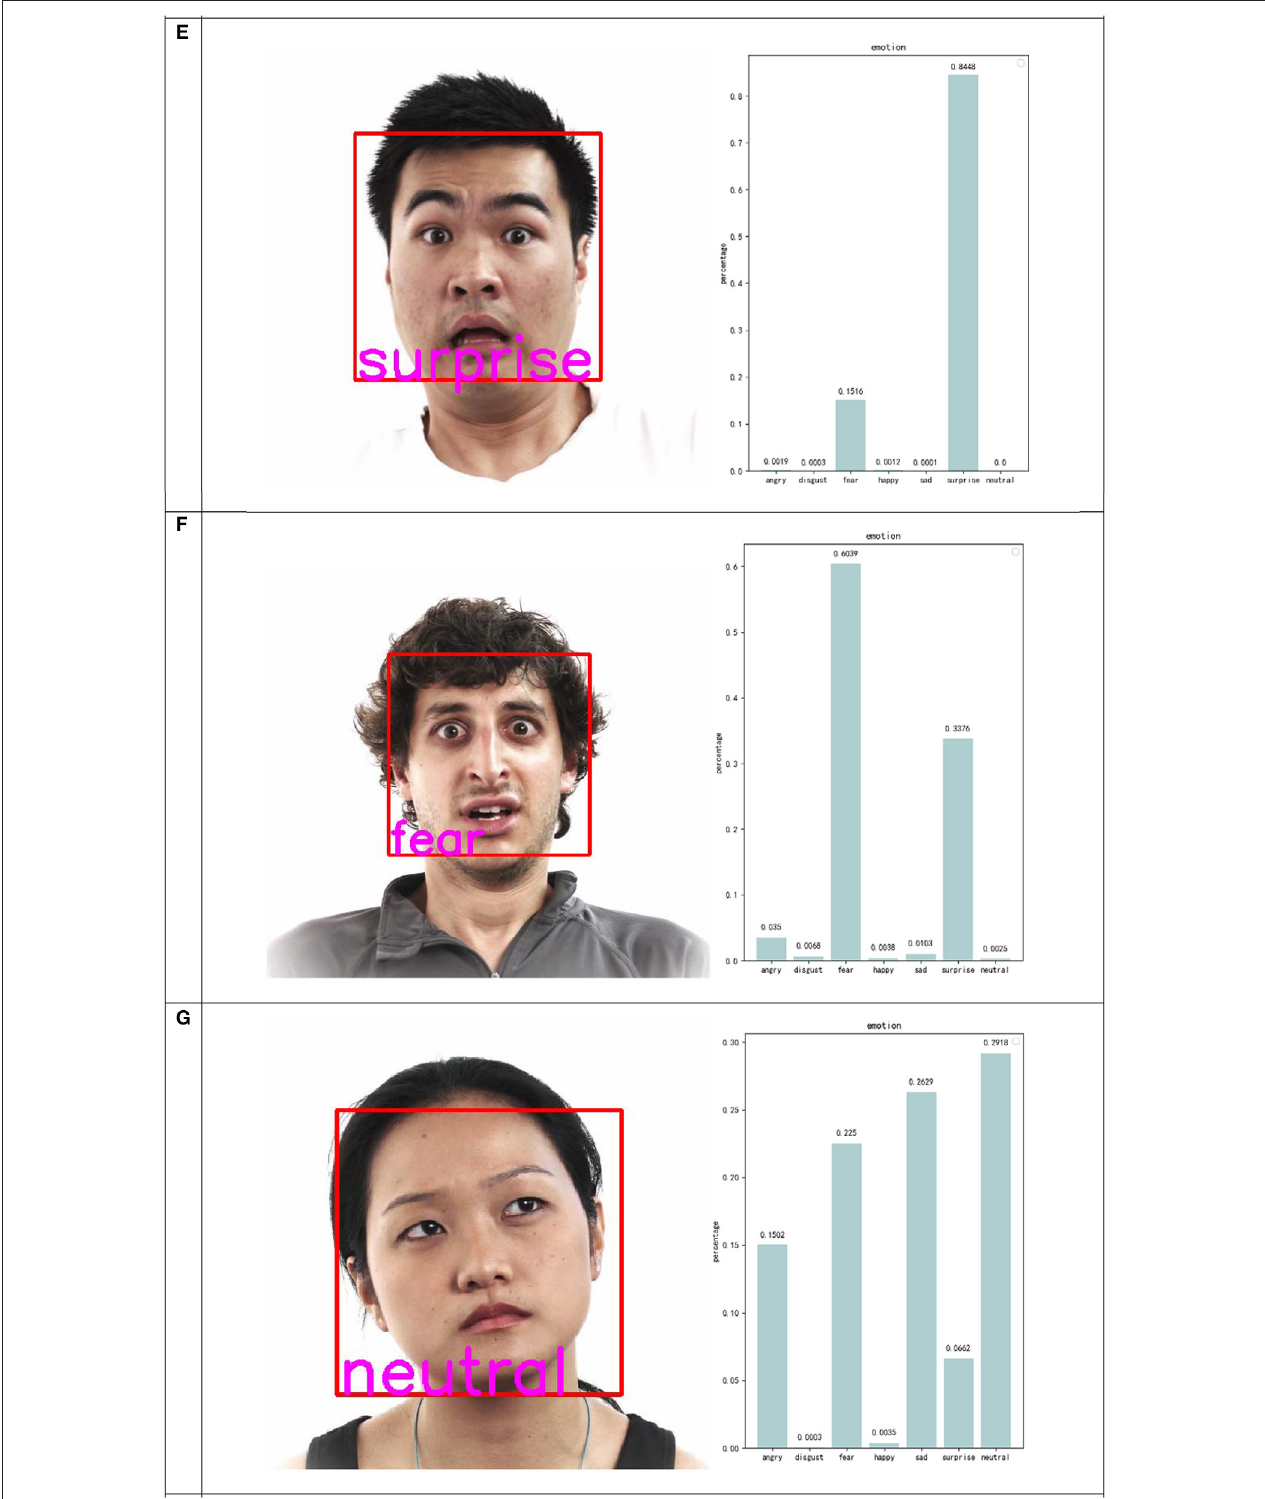
FIGURE 8 | A visualization chart of facial emotional photos: (A) happy, (B) angry, (C) sad, (D) disgust, (E) surprise, (F) fear, and (G) neutral. Facial images are from the public dataset fer2013, which can be downloaded at https://www.kaggle.com/deadskull7/fer2013.